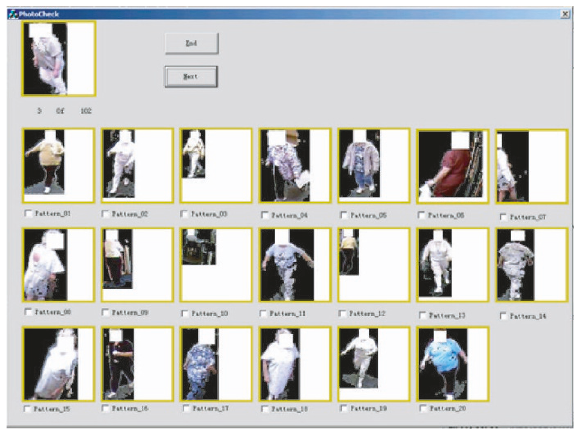
Figure 3: The interface of the labeling tool for user